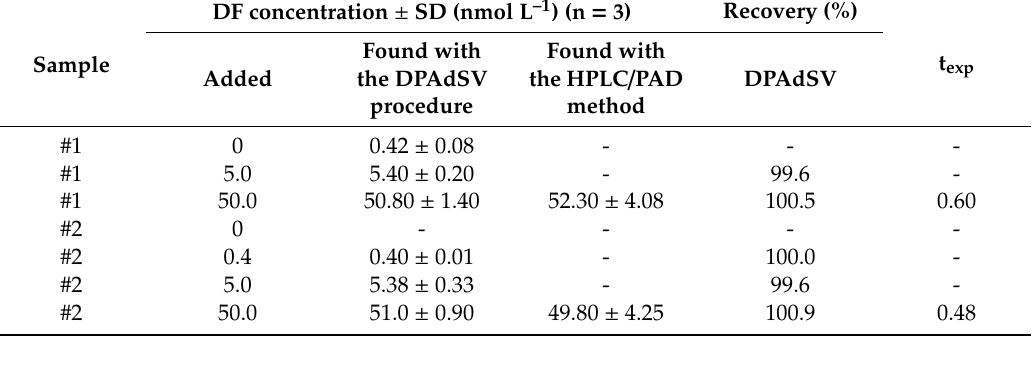
Table 4. Results of DF determination in Vistula river water samples.